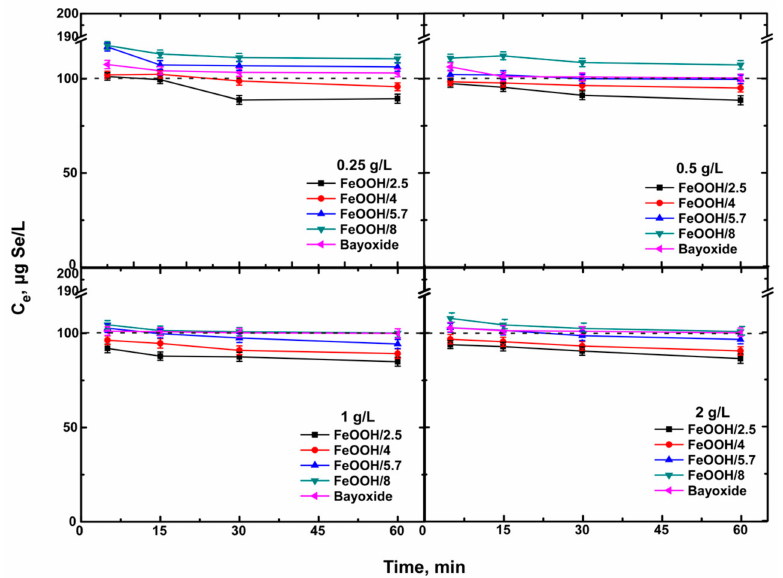
Figure 5. Adsorption of selenium species onto several FeOOHs materials in relation to adsorbent dose and to contact time. Experimental conditions: the initial concentration in the samples is a mixture containing 100 µ g Se(IV)/L and 100 µ g Se(VI)/L (i.e., total Se 200 µ g/L), at pH 7.3 ± 0.2 and temperature 20 ◦